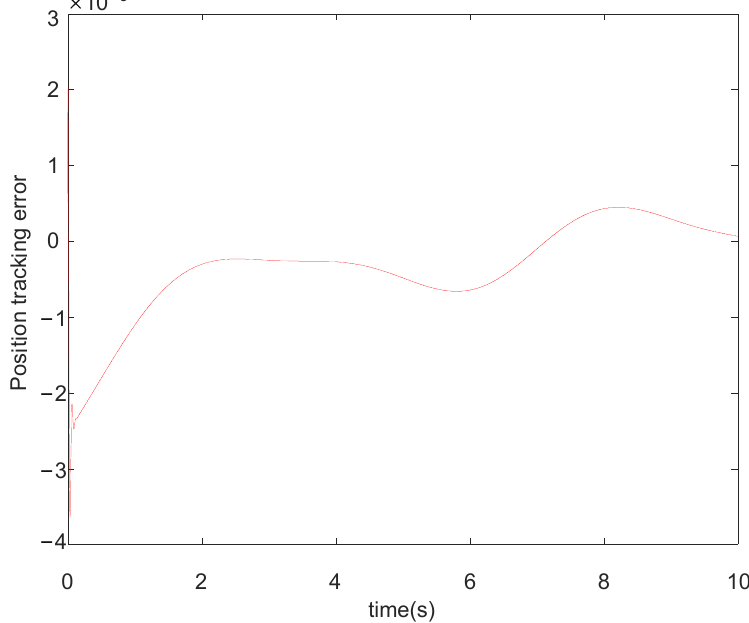
Figure 6. Position tracking error curves with error compensation.